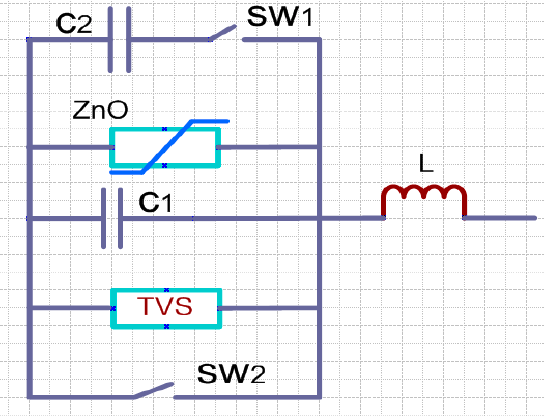
Figure 22. Configuration of hybrid FCL.